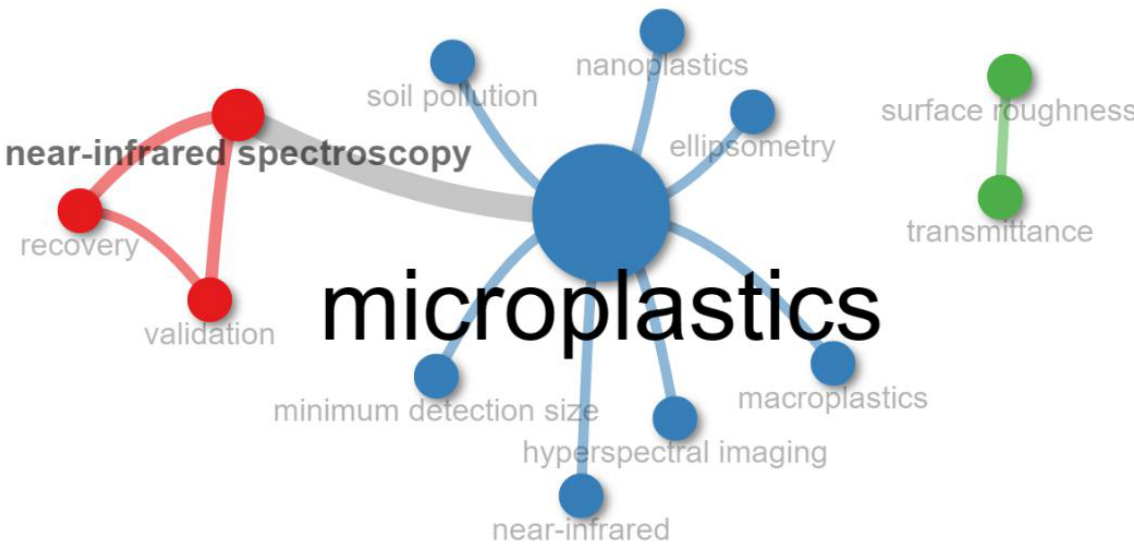
Figure 8. The Co-Occurrence Keyword Analysis for NIR-related literature. The figure was generated using the open-source tool Biblioshiny for Bibliometrix